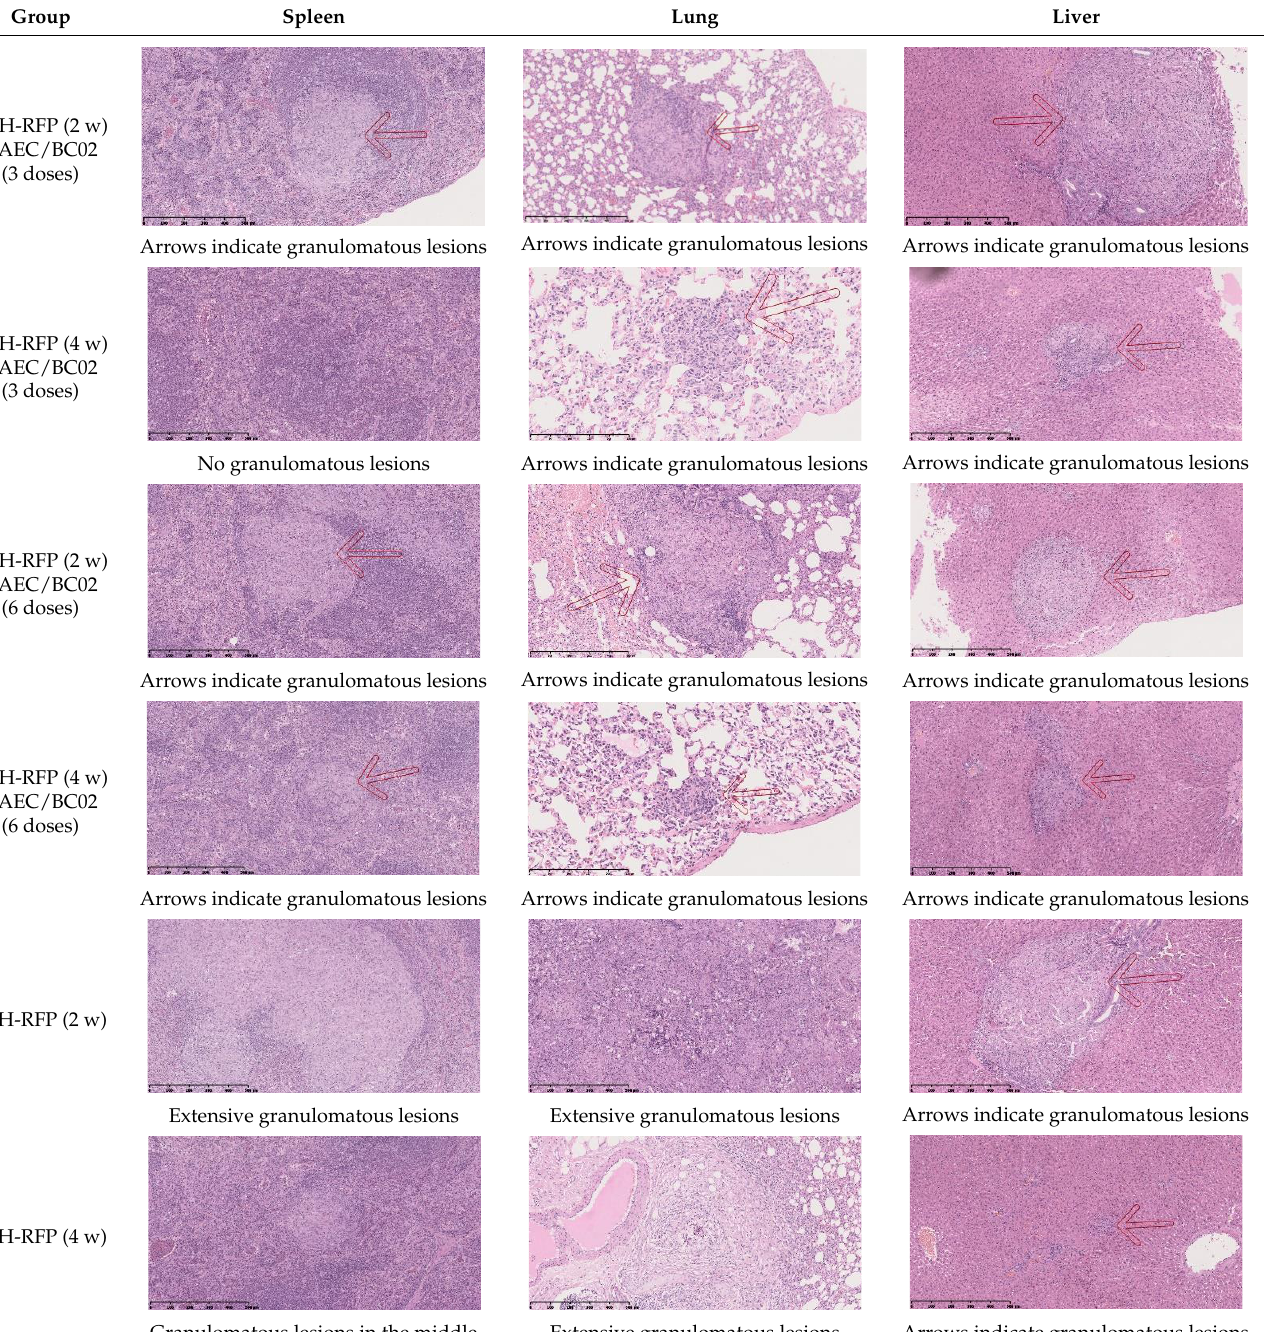
Table 3. Histopathologic examination of typical spleen, lung and liver tissues of guinea pigs in each group (HE staining, 100× magnification).